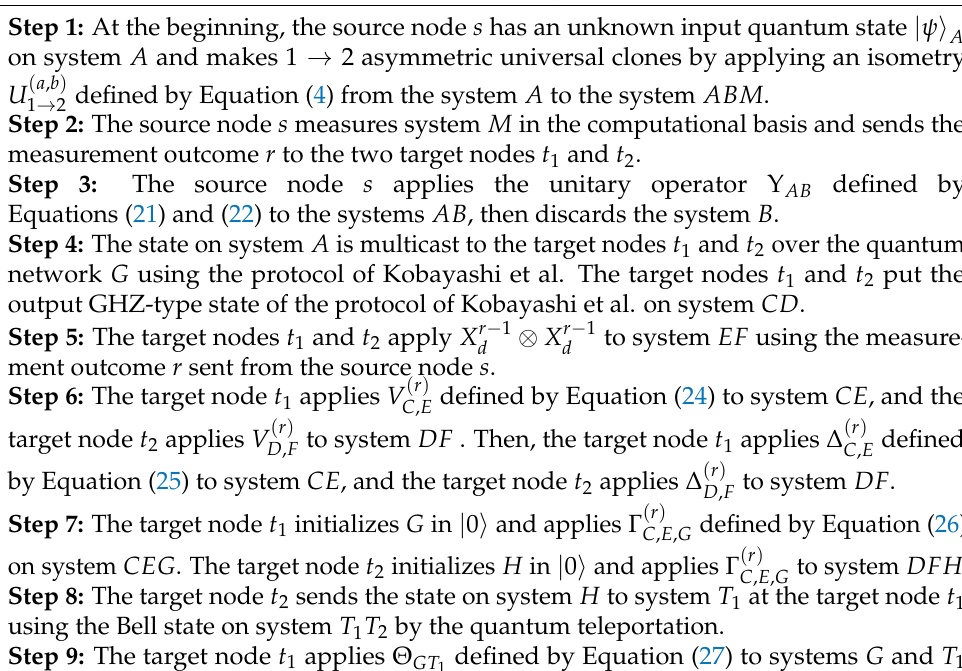
Protocol 2 1 → 2 quantum multicast network coding